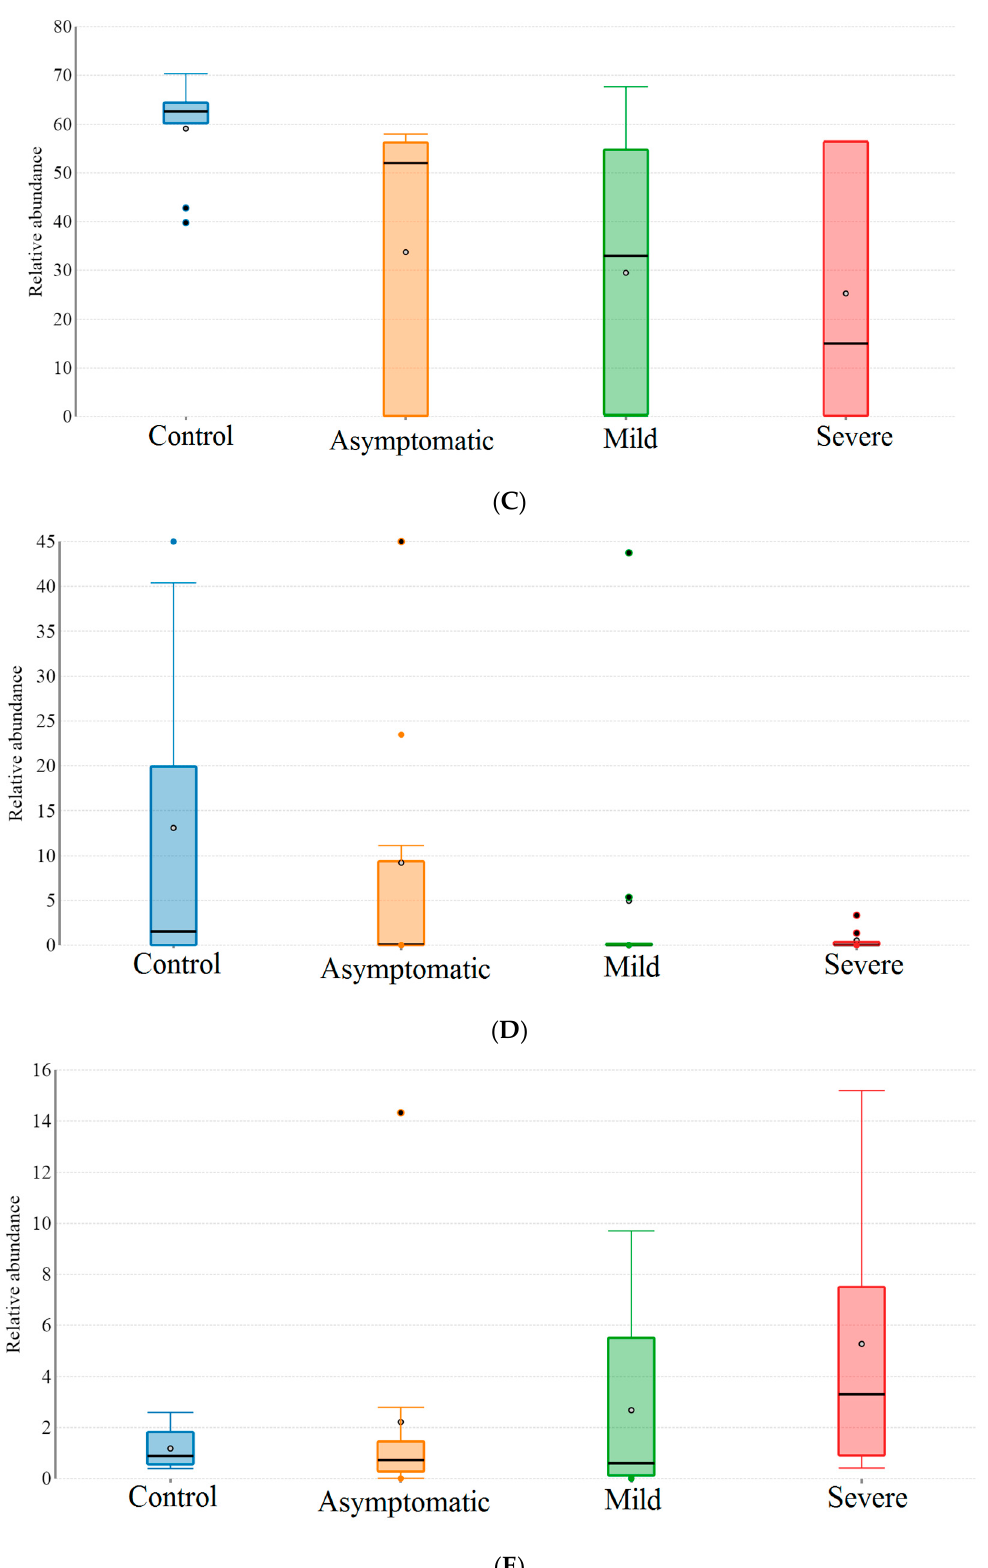
Figure 4. Box plot showing gut bacterial species abundance in healthy and COVID-19-infected groups. ( A ) Faecalibacterium prausnitzii ; ( B ) Roseburia sp.; ( C ); Prevotella ( D ); Bacteroides plebeius ( E ) Bifidobacterium .